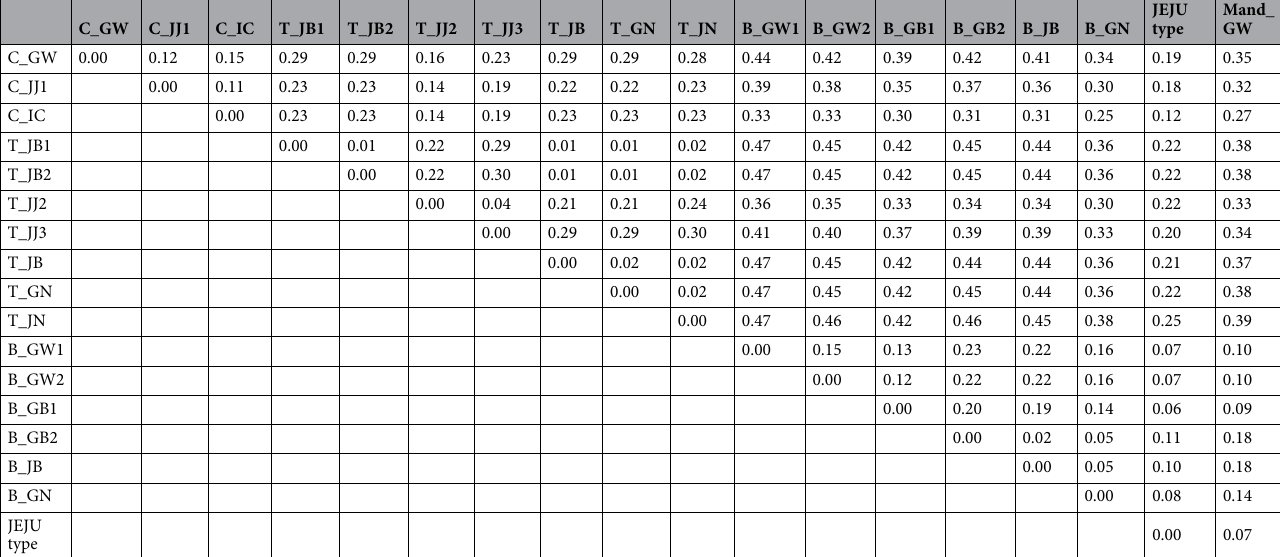
Table 2. Pairwise genetic differentiation ( F ST ) values based on 8426 SNPs from 18 Malus population in Korean peninsula. C: Malus Cultivar, T: M. toringo , B: M. baccata , JEJUtype: putative M. micromalus , Mand: putative M.